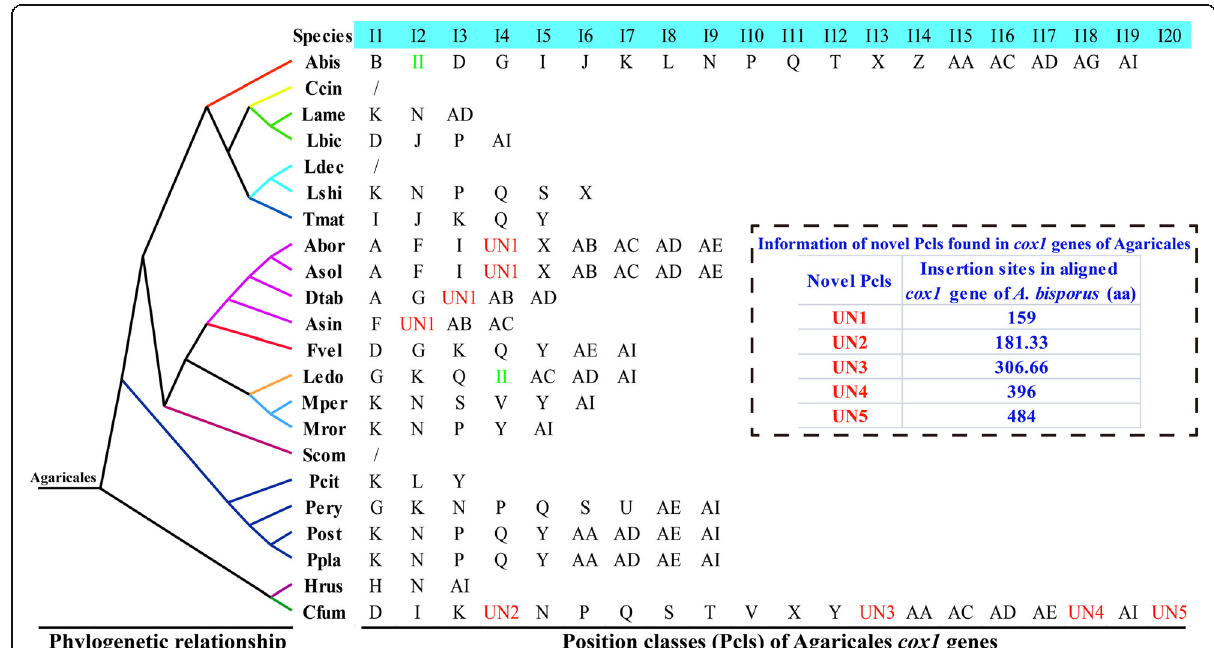
Fig. 5 Position class (Pcl) information of cox1 gene in the 22 Agaricales species. Introns of cox1 genes of the 22 Agaricales mitogenomes were classified into different position classes (Pcls) according to the method described by Férandon et al. (2010). II represents group II introns, and UN represents novel introns never detected in previous studies. The phylogenetic positions of 22 Agaricales species were established using the Bayesian inference (BI) method and Maximum Likelihood (ML) method based on concatenated mitochondrial genes. Species information is shown in Supplementary Table